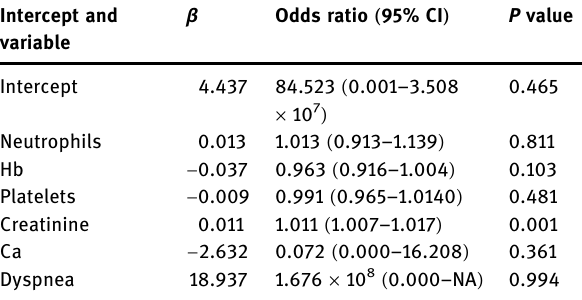
Table 3: Prognostic factors in patients with severe HFRS Intercept